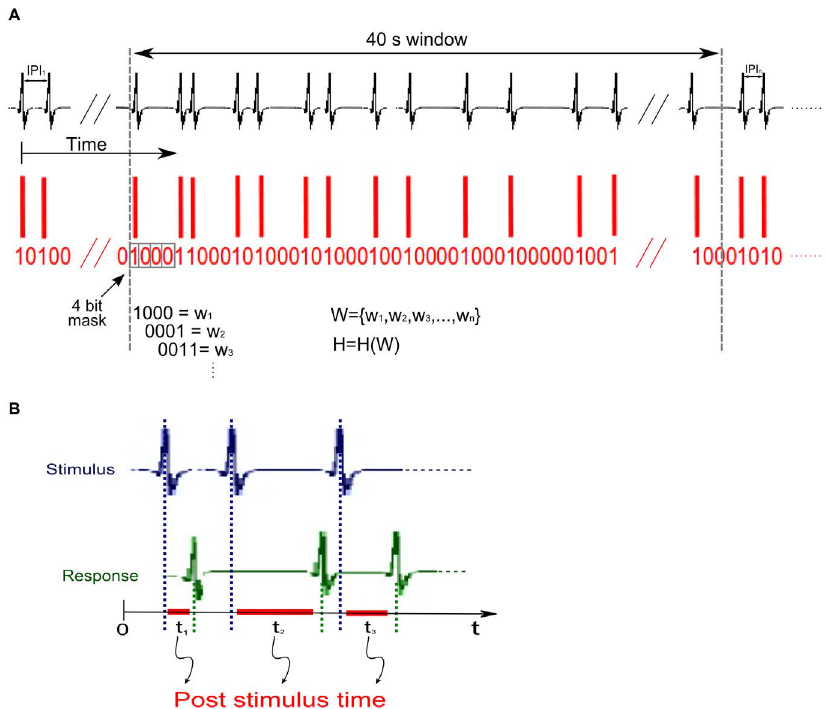
Figure 3. Data analyzes: binarization, entropy and post stimulus calculations. A – Binarization and set of patterns for entropy calculations. The time axis is discretized into small bins. The presence of an EOD in each bin is represented by 1, whereas an absence is represented by 0. Timestamp sequences are analyzed in bit strings obtained in 40 s windows. Each pattern is a 4 bit word. Starting from the beginning of the bit string a 4 bit mask is moved 1 bit to the right to extract a new word until the end of the window, forming the set of words W= { w 1 , w 2 , w 3 ,…, w N }. From the set of probabilities of each word w i we computed the entropy H (W). B – Post stimulus time (PST) is defined as the time intervals (in red) ti between stimulus pulses (in blue) and the fish response ones (in